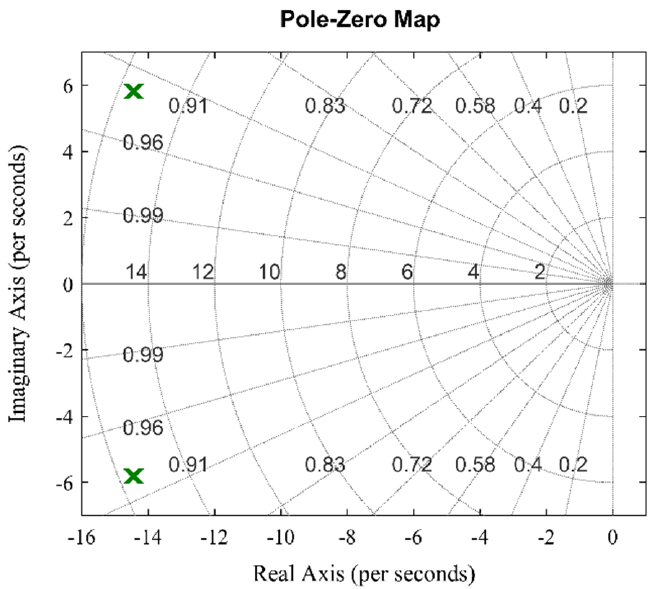
Figure 10. Pole-zero plot of closed-loop transfer function of speed